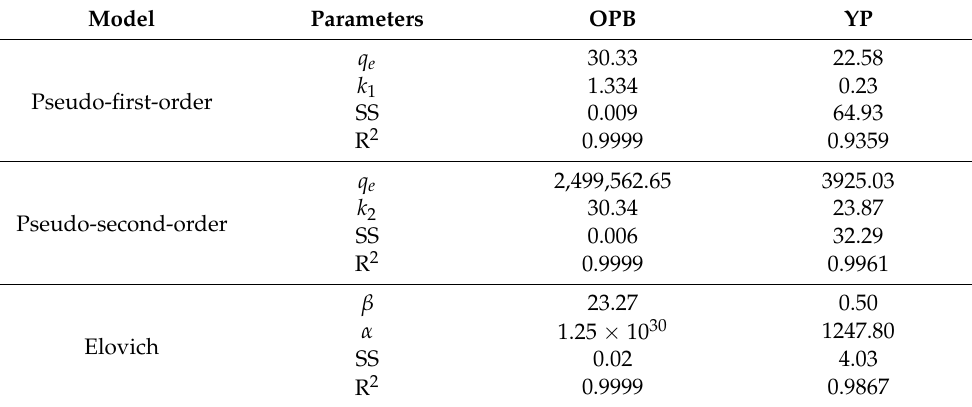
Table 8. Adjustment parameters of kinetic